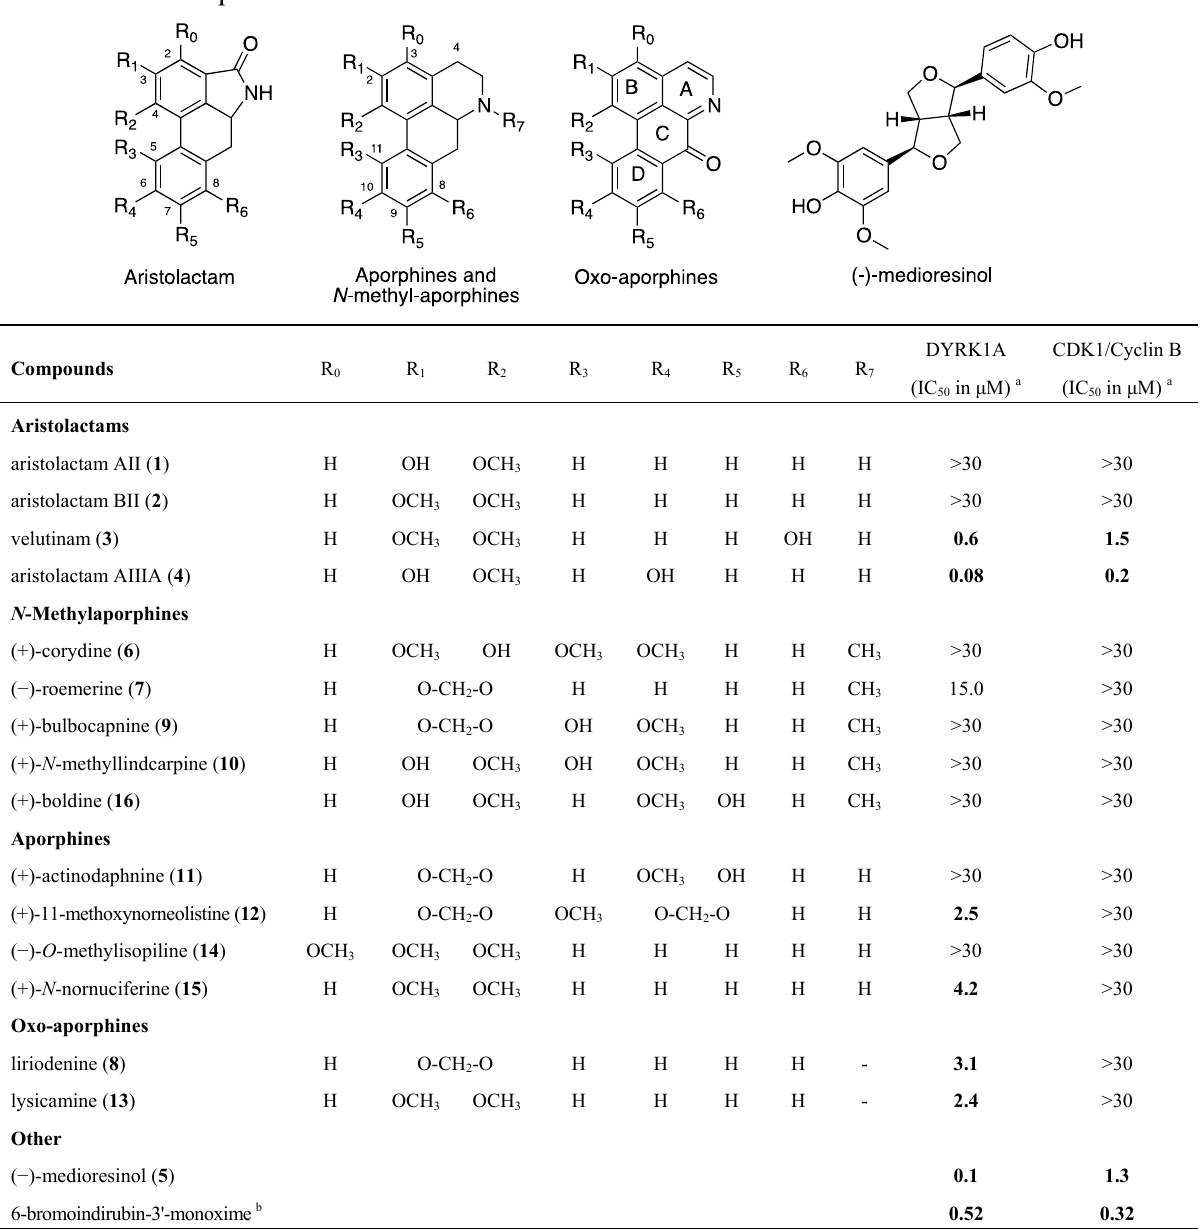
(Table 1). Velutinam ( 3 ), aristolactam AIIIA ( 4 ) and ( − )-medioresinol ( 5 ) showed the